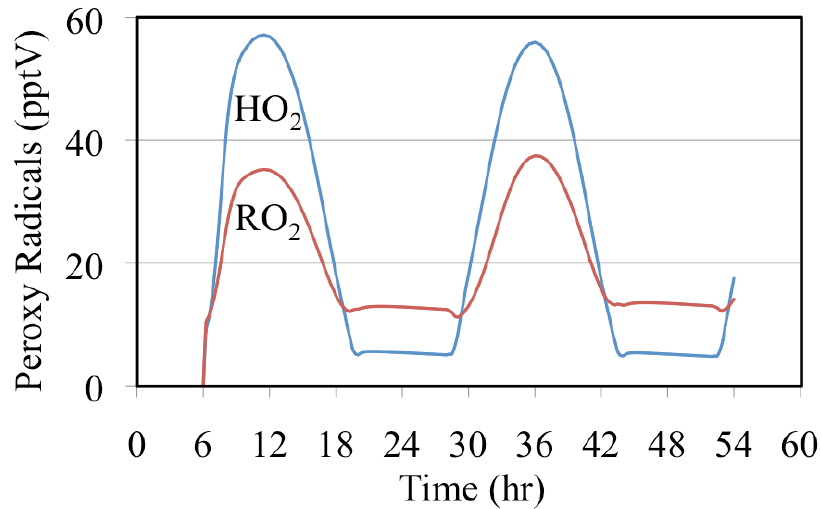
Figure 21. The mixing ratio of HO 2• and the total mixing ratio of organic peroxy radicals are shown for the polluted urban atmosphere